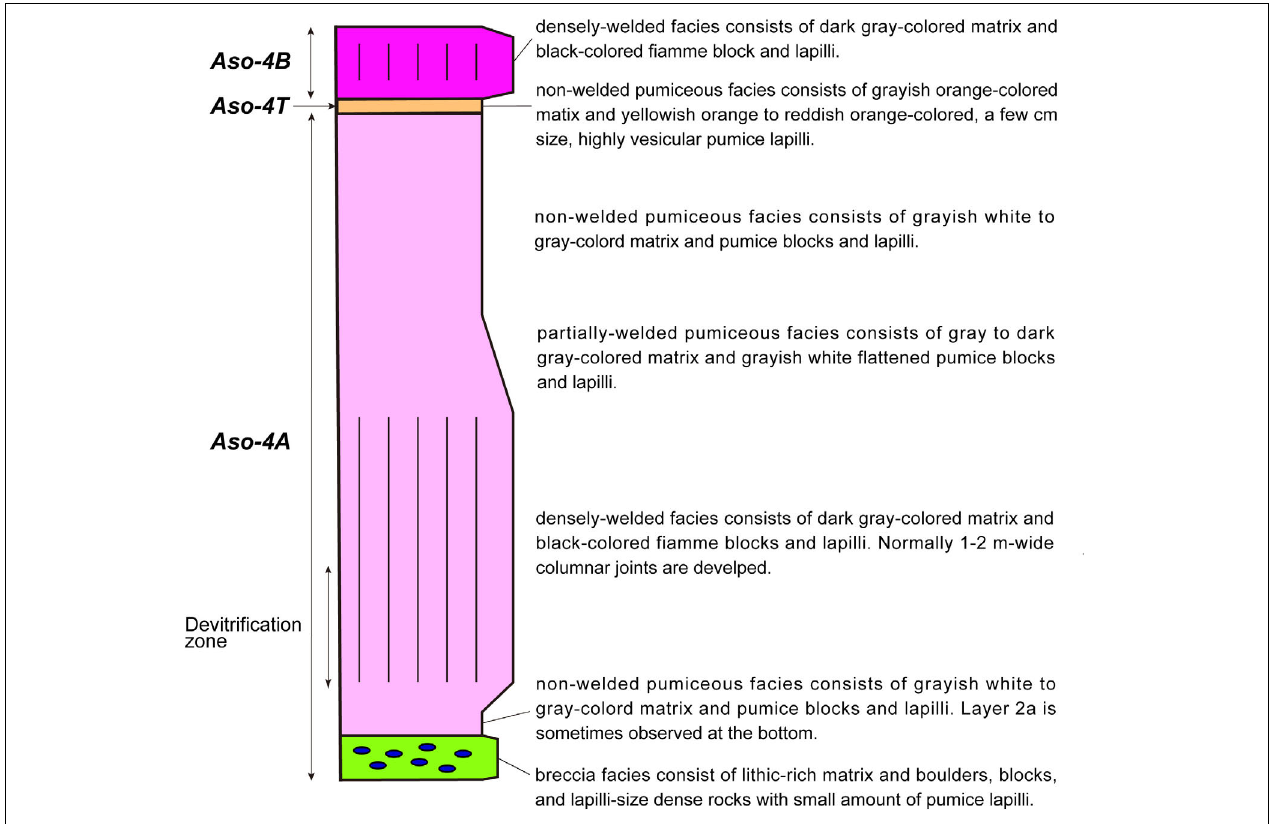
FIGURE 2 | Schematic columnar section of Aso-4 PDC deposit at the north and eastern side of Aso caldera